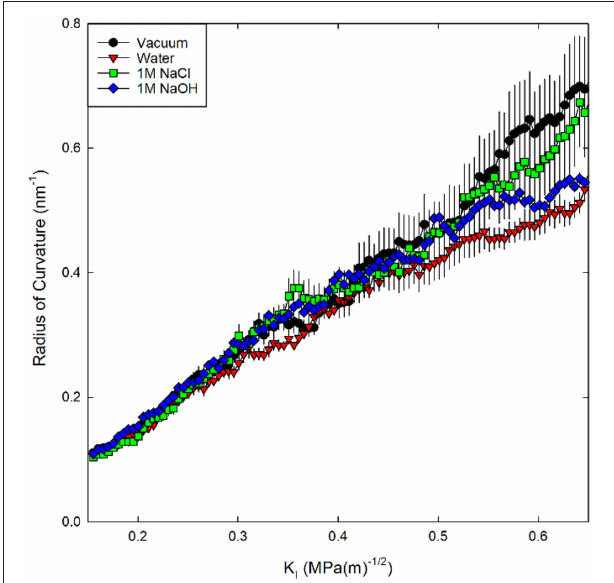
FIGURE 7 | Radius of curvature for silica systems in four chemical